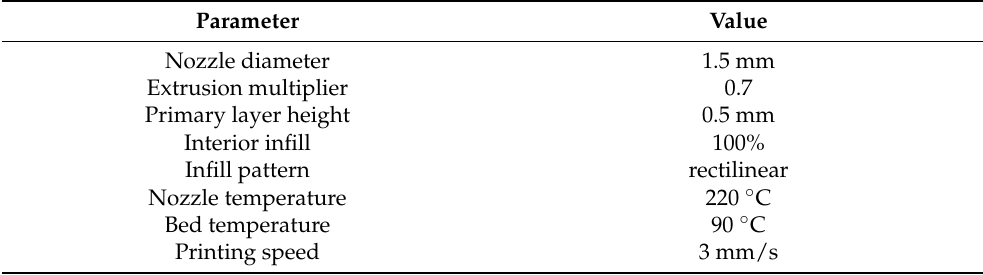
Table 2. Printing